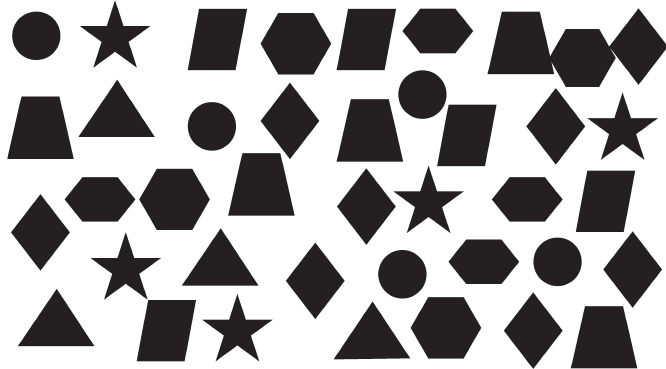
Figure 1. Examples of the shapes that appeared in the task (source: crated by